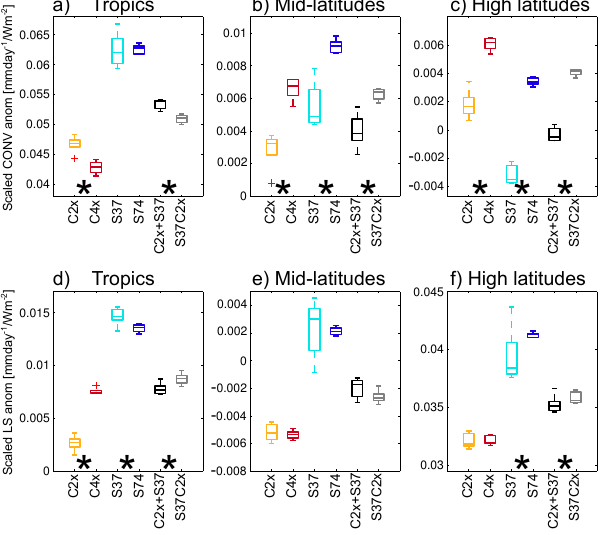
Fig. 5. Annual mean anomalies for convective (CONV) and large-scale (LS) precipitation in the tropics (a and d respectively), the mid-latitudes (b and e respectively) and the high latitudes (c and f respectively). Anomalies in all scenarios are scaled with their respective adjusted forcing and units are therefore [mmday − 1 Wm − 2 ]. See text for definition of the regions and val- ues of the adjusted forcing in each scenario. Asterisks are dis- played whenever the pairs of scenarios (C2x and C4x, S37 and S74, S37C2x and C2x+S37) are significantly different (two-sample Kolmogorov–Smirnov test, significance level 0.05) and therefore indicate when the linear additivity assumption is not valid. Red crosses are outliers.